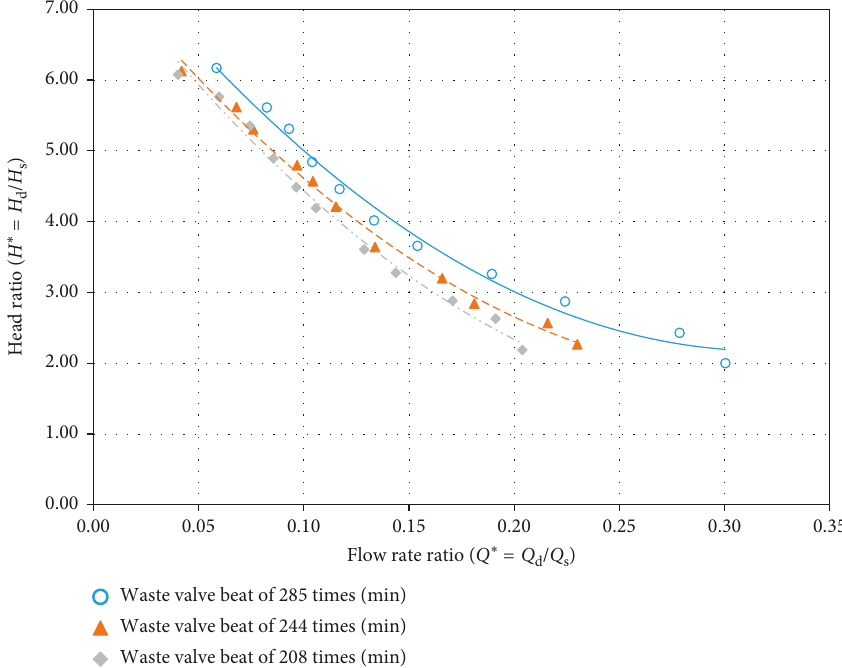
Figure 13: Head ratio vs. flow-rate ratio at different waste valve beat rates, f